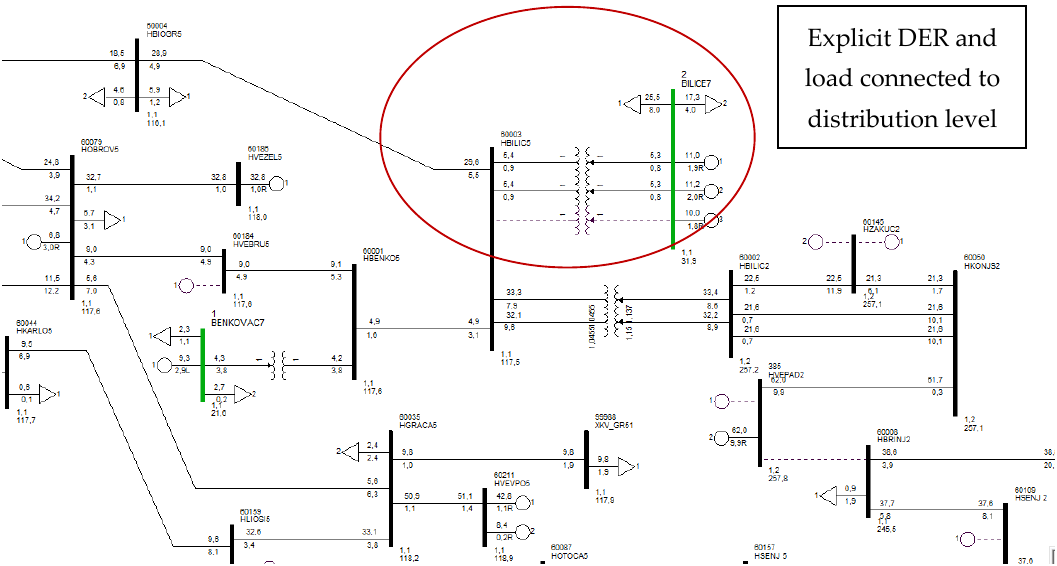
Figure 5. Calculated power flow and voltages of analysed power transmission system–explicit DER and load–downstream load flow.